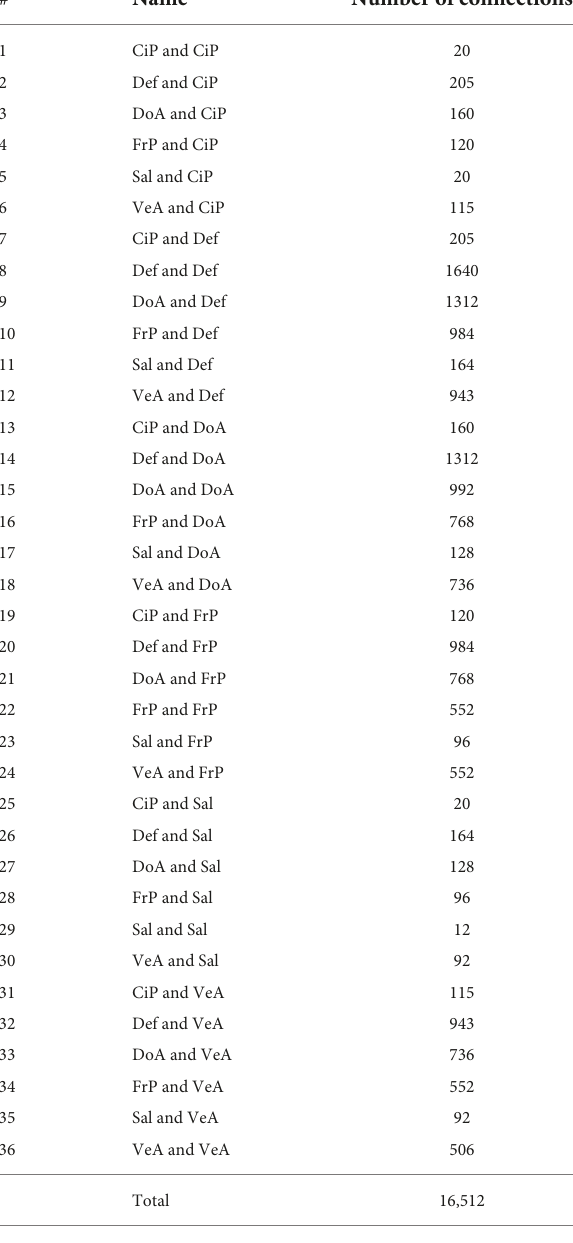
TABLE 1 List of all 36 functional network pairs tested in the ANOVA with the number of ROI connections between networks listed in the third column. Grouping of connections per functional system pair.